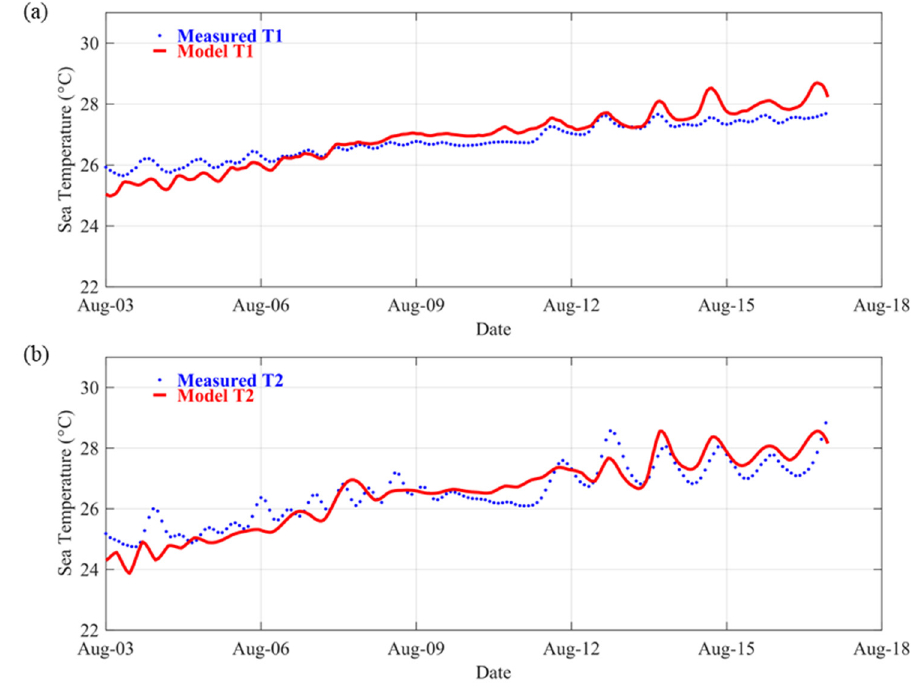
Figure 2. Verification of ( a ) water level, ( b ) current velocity and ( c ) direction (1–30 April 2018).